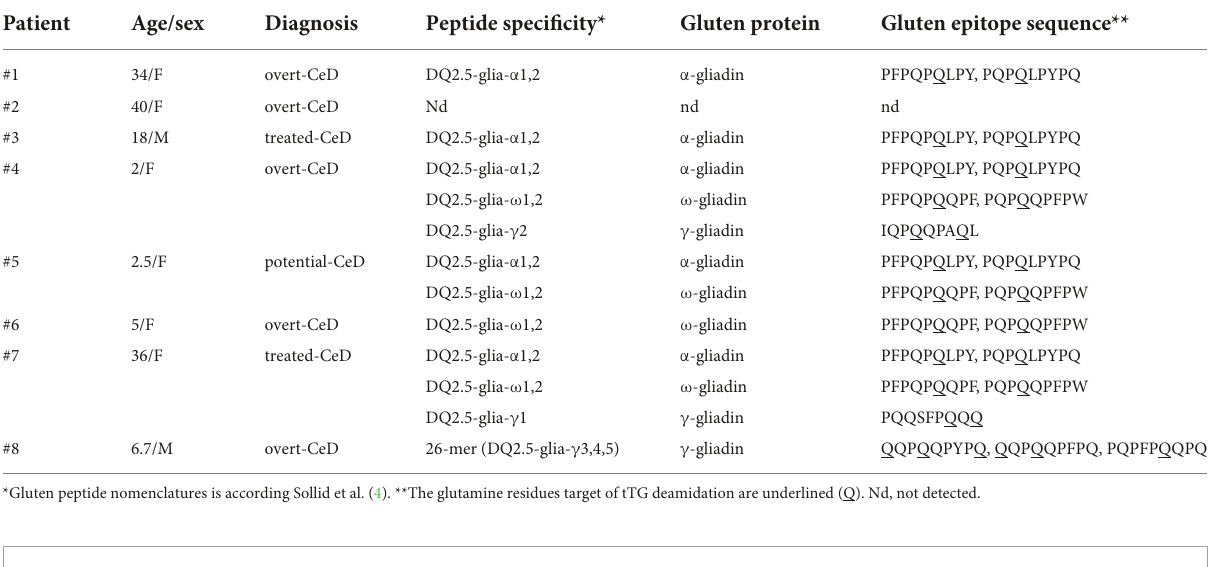
TABLE 1 Enrolled celiac patients for functional T-cell experiments and gluten peptide specificity.